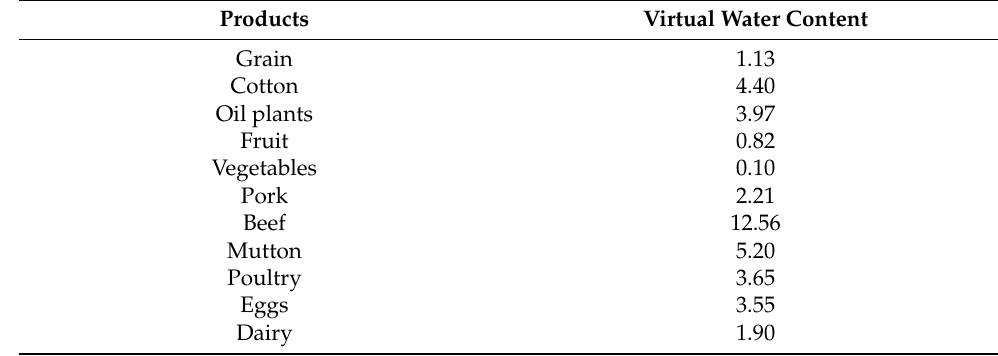
Table 1. Virtual water per unit of crop products and livestock products (m 3 /kg) [35,52,53]. Products Virtual Water Content